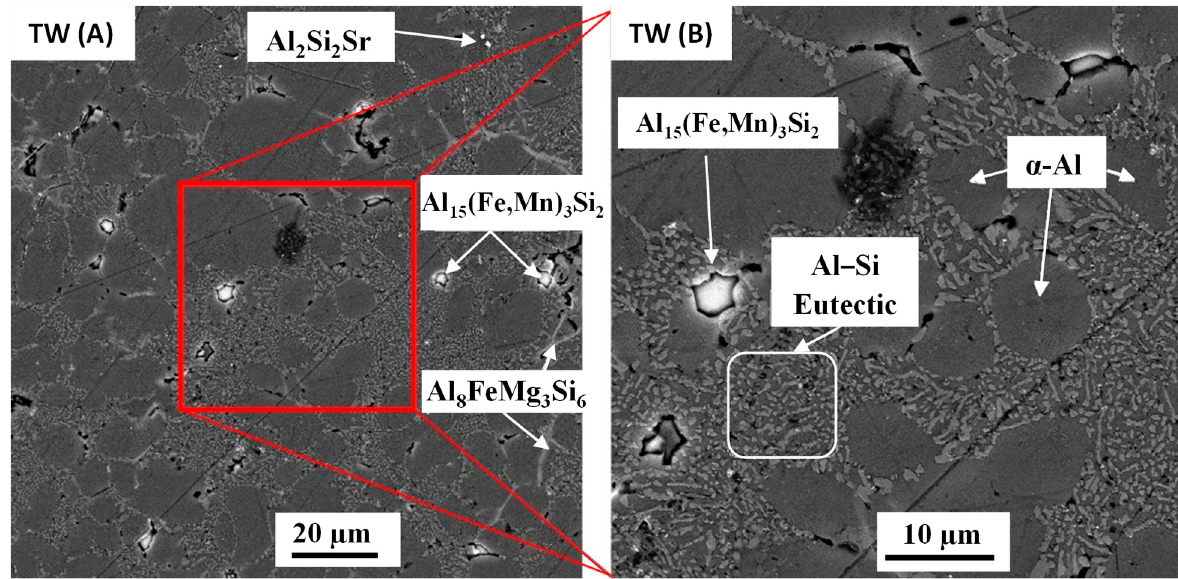
Figure 9. Micrograph showing the TS specimen: ( A ) representative primary phases; ( B ) close-up of the red box region in ( A ).